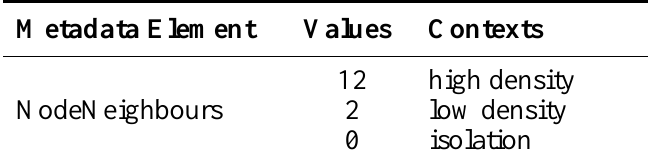
Table 3. Example of contexts depending on metadata values.